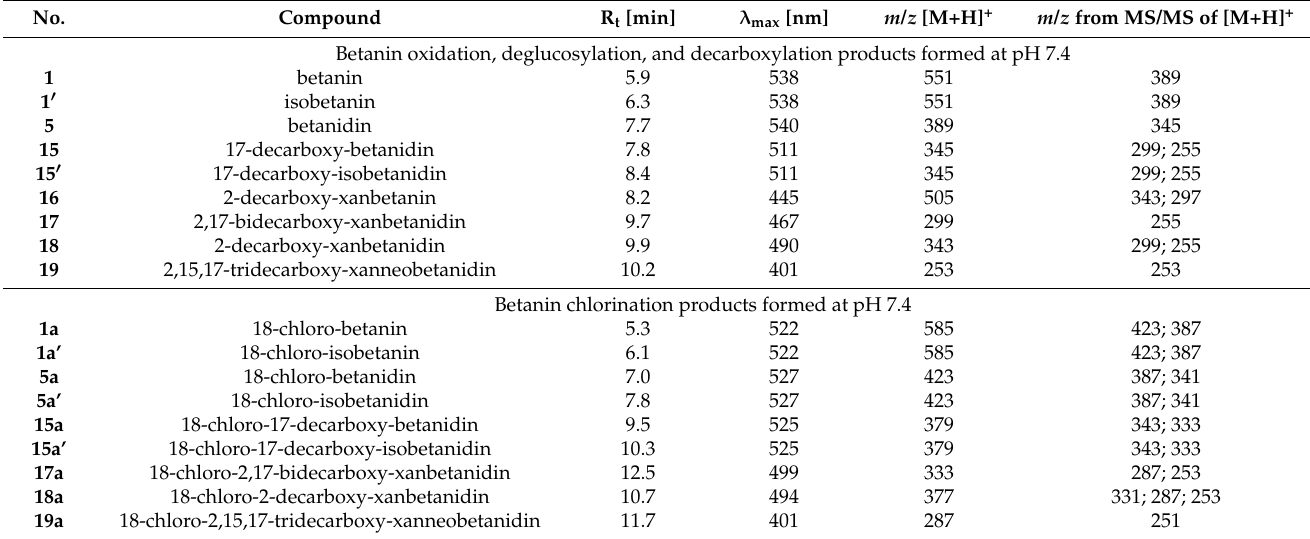
Table 2. Chromatographic, spectrophotometric, and mass spectrometric data of the products of betanin oxidation, chlorina- tion, deglucosylation, and decarboxylation induced by NaOCl at pH 7.4.